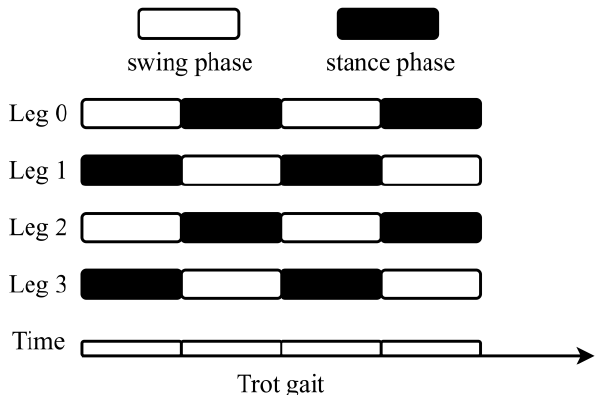
Figure 10. Stance phase and swing phase of trot gait.